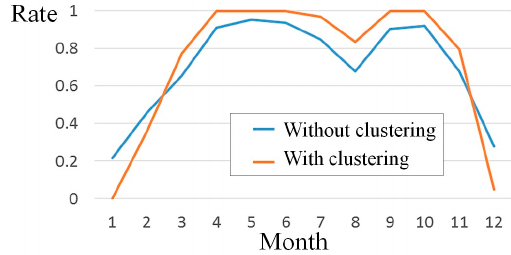
Figure 9. Rate of self-sufficient grids. Blue indicates the rates of grids whose storage sufficiency is positive, and is calculated as [the number of grids with positive storage-sufficiency]/6,687. Red indicates the rates of grids that are in community clusters with positive storage sufficiency, and is calculated as [the number of grids in a cluster, G i , with positive storage-sufficiency]/6,687. The total number of grids is 6,687.